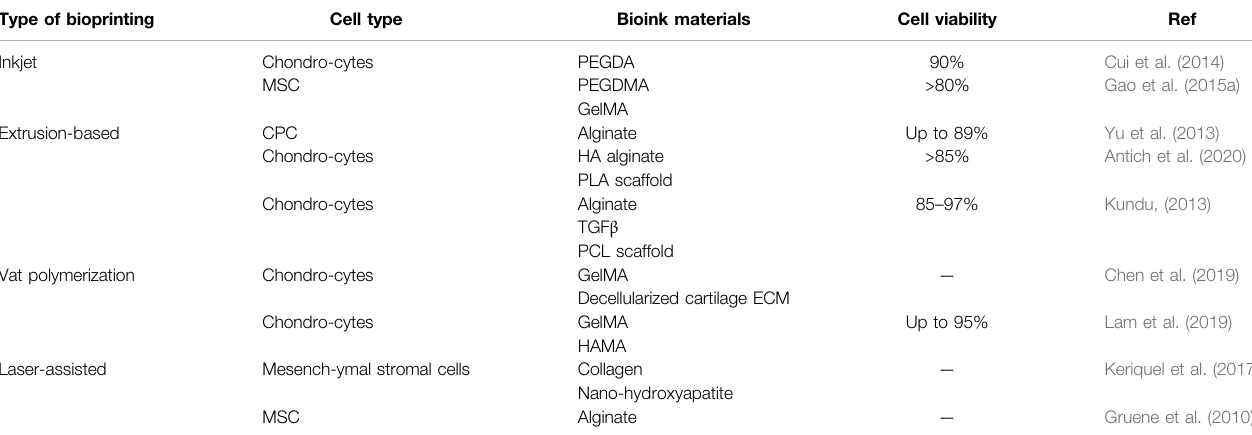
TABLE 1 | Examples of cartilage tissue constructs printed using different bioprinting